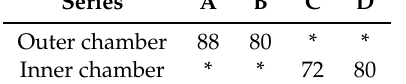
Table 1. Glycerin content (volume percentage) of the two chambers for the different measurement series. An asterisk (*) denotes that this part was not included for the particular series. Series A B C D Outer